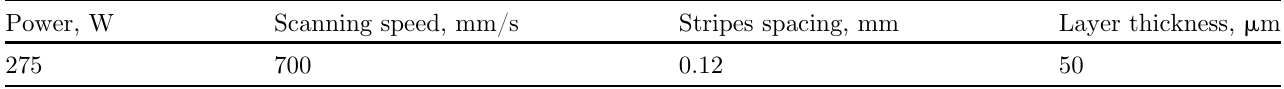
Table 3. LPBF process parameters.